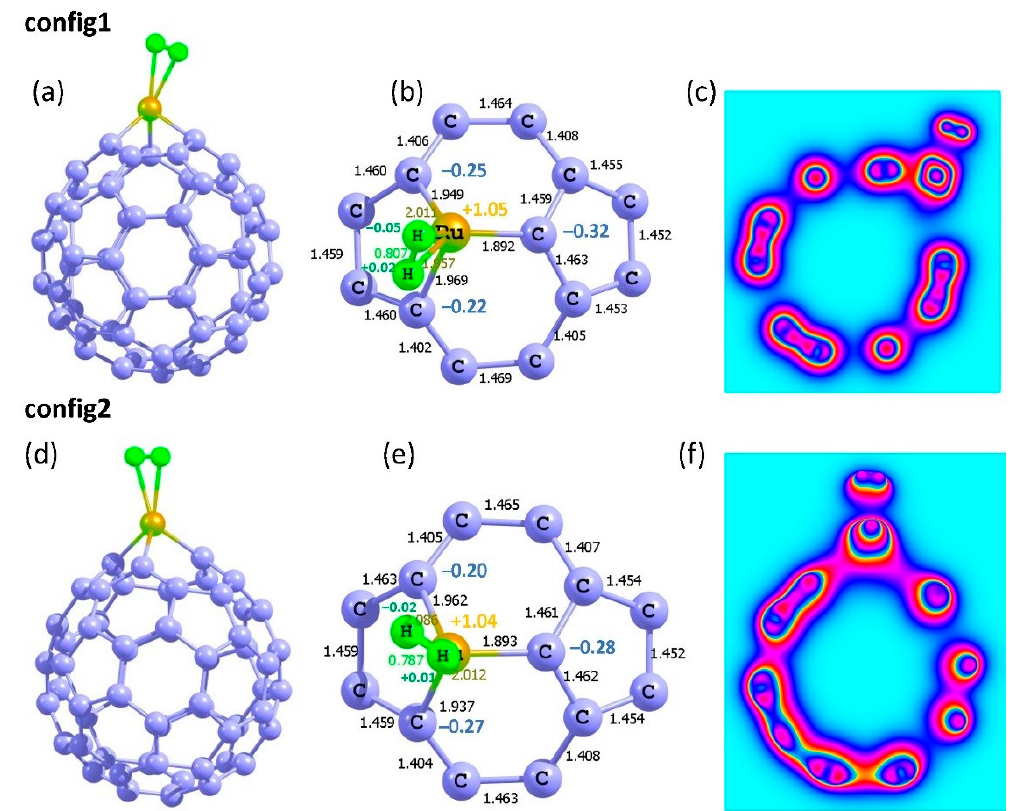
Figure 11. ( a ) Relaxed configuration (configuration 1) of molecular hydrogen adsorbed on the surface of Ru-doped C 60 , ( b ) bond distances (H–H and C–C) in the relaxed configuration and ( c ) charge density plot showing the interaction of molecular hydrogen with Ru-doped C 60 . Similar figures ( d – f ) are shown for configuration